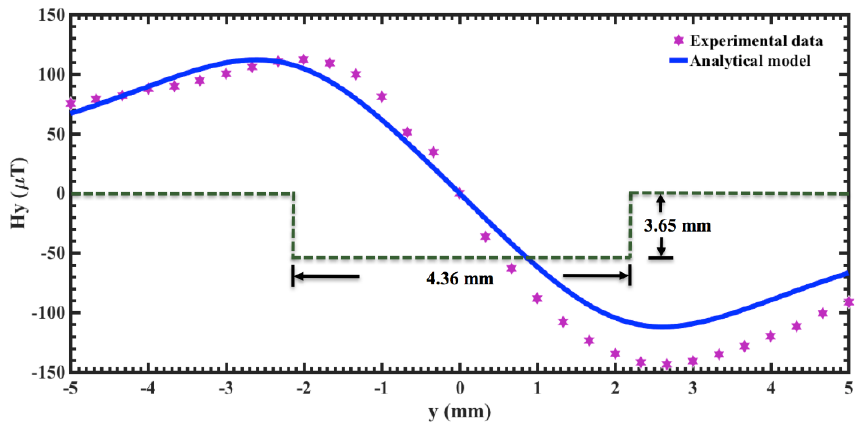
Figure 6. Normal MMM signal of the rectangular defect S1 of the ASTM A-36 steel pipe.